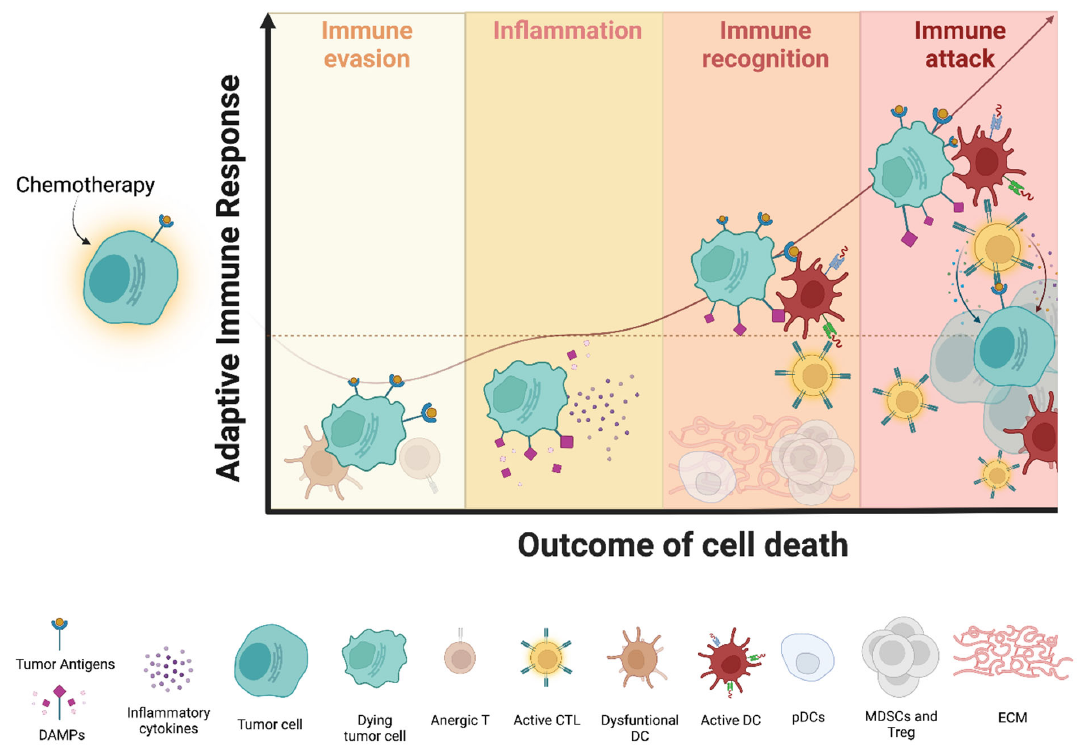
Figure 2. The outcome of cell death on adaptive immunity. The perception of chemotherapy-induced cell death by the immune system and the extent of the activation of adaptive immunity rely on the coexistence of antigenicity, adjuvanticity, and a permissive microenvironment. During cell death, four different scenarios can be hypothesized: (i) immunogenic neo-antigens with poor co-stimulatory signals and poor adjuvanticity lead to T cell tolerance and anergy, thus favoring immune escape; (ii) adjuvanticity (provided by DAMPs) associated with insufficient antigenicity may trigger only cell death-induced “inflammation”; (iii) antigenicity and adjuvanticity together can effectively stimulate adaptive T cell recognition of cancer cells, although an immunosuppressive microenvironment can still limit anti-tumor attack; (iv) the presence of a permissive microenvironment amplifies immune attack by allowing for immune infiltration and T cell–mediated killing. Abbreviations: DAMPs, damage-associated molecular patterns; CTL, cytotoxic T lymphocytes; DC, dendritic cell; pDC, plasmacytoid DC; MDSCs, myeloid-derived suppressor cells; Treg, regulatory T cells; ECM, extracellular matrix